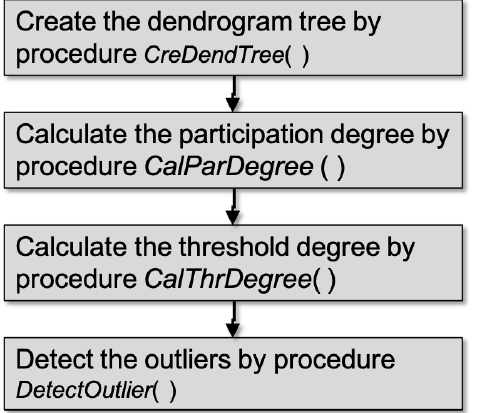
Figure 2. Schematic diagram of the fault detection based on participation degree (FDP)